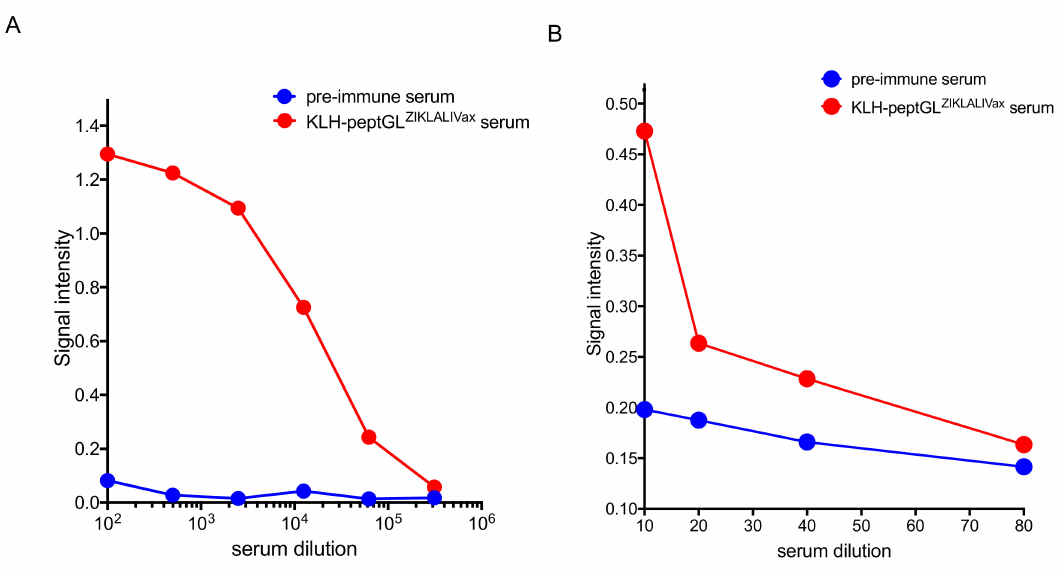
Figure 4. Antigenic reactivity of mouse KLH-peptGL ZIKALIVax immune sera. The O.D 450 or signal intensity of serum samples through peptide-based ELISA. Pre-immune sera and immune sera from BALB / c mice that received KLH-peptGL ZIKALIVax conjugates were pooled and then tested with KLH-peptGL ZIKALIVax conjugate ( A ) or free peptGL ZIKALIVax ( B ) as coating antigen. Serum samples of BALB / c mice twice inoculated with KLH-peptGL ZIKALIVax conjugates were tested individually using peptGL ZIKALIVax through peptide-based ELISA. Among the five individual KLH-peptGL ZIKALIVax immune sera tested, only a serum sample from